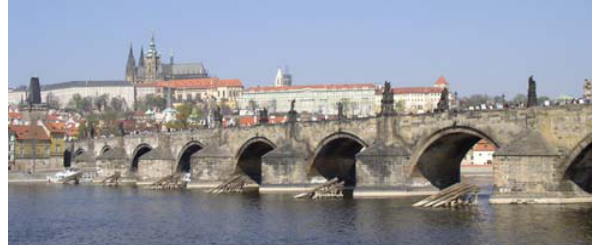
Fig 1. Charles Bridge with 16 arches and a clear span of 16,62 m to 23,38. The overall bridge length is 515,76 m and it is 9,4 m wide. The dimensions of massive stone piers at the arch footing range between 8,5 m and 10,84 m by 24,0 m to 25,0 m. Pier heads have been “sharpened“ against the water stream at an angle of 65 o . The bridge